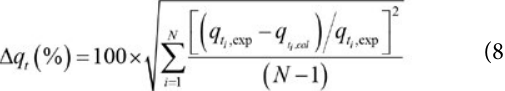
(%) values are listed in Table 2. The pseudo-first-order ki- netic model gives Δ q (%) as high as 83% while the pseudo- t second order and Elovich models give Δ q (%) values ran- t ging from 1.4–3.5% and 0.50–1.2%, respectively. Based on the correlation coefficients (R 2 ) and normalized standard deviation Δ q (%) values, the 2,4,6-TCP adsorption on t PBP is best described by the Elovich model